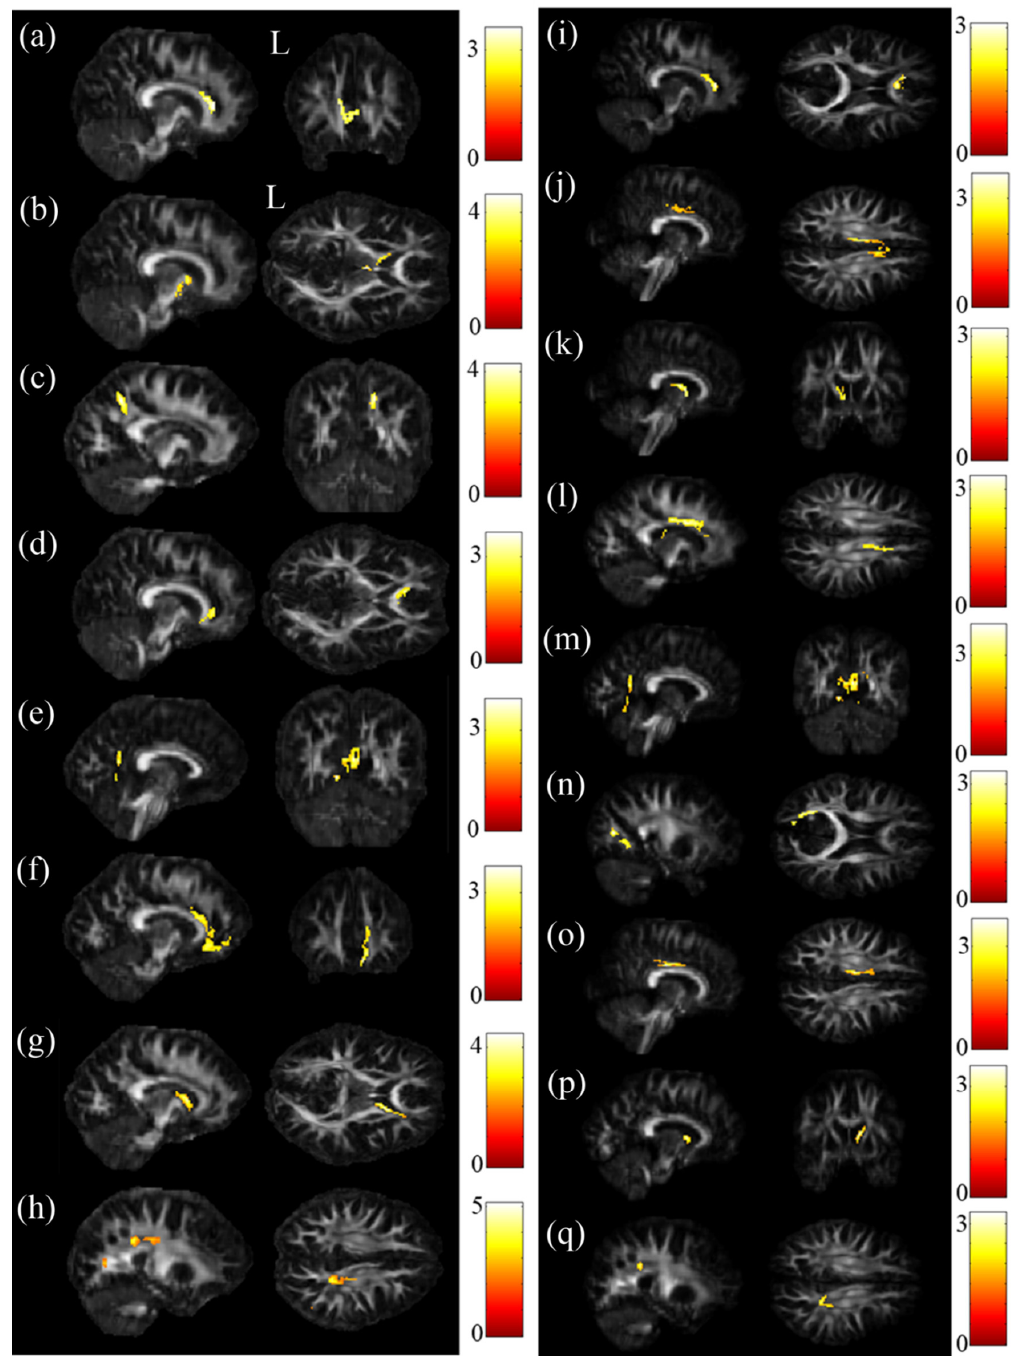
Figure 2. Post hoc t-test results. Compared with the HC group, significantly lower GFA values in the ( a ) corpus callosum, cingulate gyrus, ( b ) caudate and ( c ) precuneus occurred in the SA group. Compared with the D group, the SA group had significantly lower GFA values in the ( d ) corpus callosum and ( e ) precuneus. Compared with the HC group, the D group had significantly lower GFA values in the ( f ) cingulate gyrus, ( g ) caudate and ( h ) precuneus. Compared with the HC group, significantly lower NQA values in the corpus ( i ) callosum, ( j ) cingulate gyrus and ( k ) caudate occurred in the SA group. Compared with the D group, significantly lower NQA values in the ( l ) corpus callosum, ( m ) precuneus and ( n ) cuneus occurred in the SA group. Compared with the HC group, the D group had significantly lower NQA values in the ( o ) cingulate gyrus, ( p ) caudate and ( q ) precuneus ( p < 0.05, cluster size > 100, color bar: t scores).